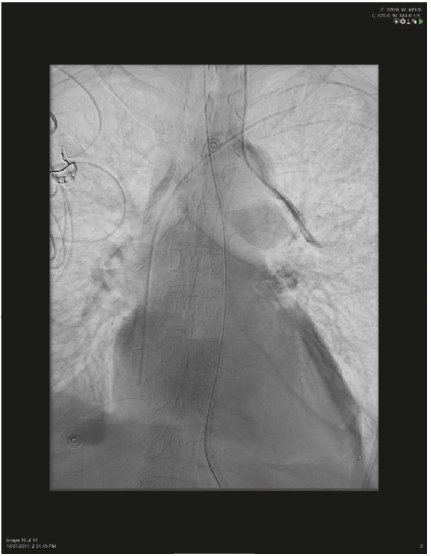
Figure 2: Fluoroscopy study showing left IJ CVL extending through the anomalous pulmonary